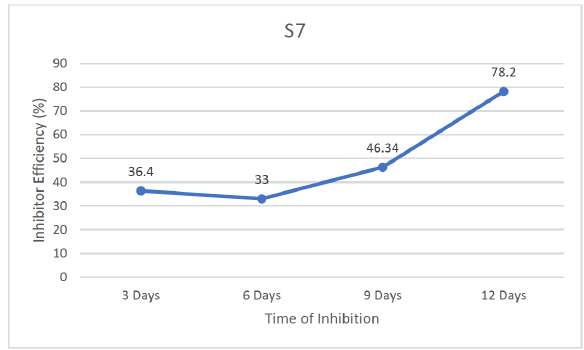
Figure 7: Plot of S7 (Inhibition eflciency versus Time of inhibition (days).